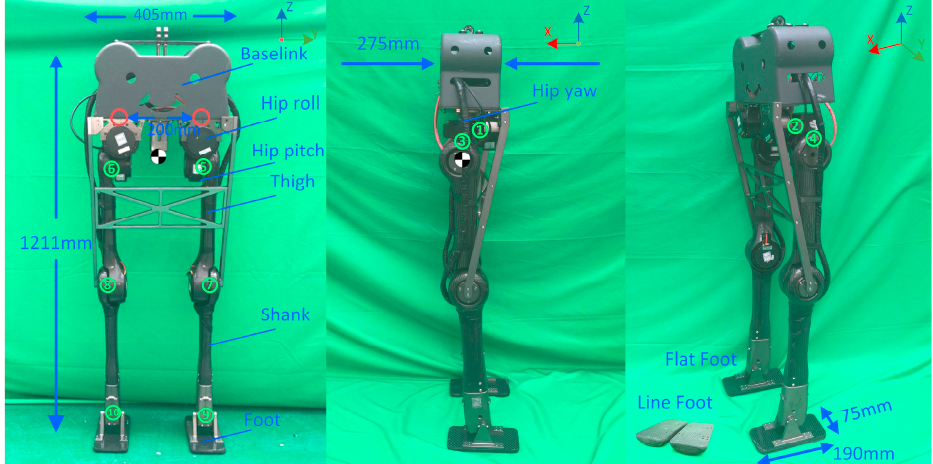
Figure 2. Composition and size of the robot. The left diagram shows joint distribution that fixed joints marked in red and actuated joints numbered in green. The middle diagram shows that the width of the robot is 275 mm. Two types of feet are shown in the right diagram and the length of the feet used in this paper is 190 mm and the width is 75 mm.